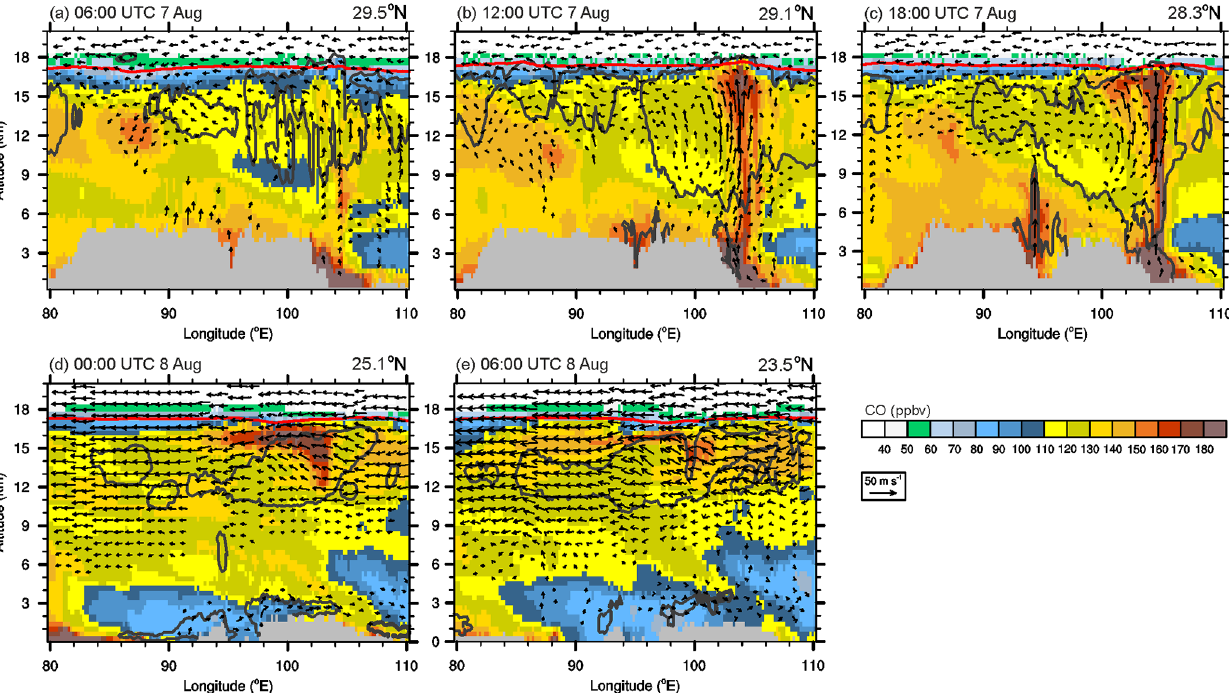
Figure 8. Vertical cross sections of CO concentration (ppbv) from 0.1 to 20km altitude at (a) 06:00UTC, (b) 12:00UTC, (c) 18:00UTC on 7 August, (d) 00:00UTC, and (e) 06:00UTC on 8 August 2017. The isentropic altitudes of 380K is depicted by the red lines. The cloud boundary (mixing ratio of ice content of 10mgkg − 1 ) is contoured by the black line while wind stronger than 5ms − 1 is shown by vectors. In each panel, grey areas indicate the